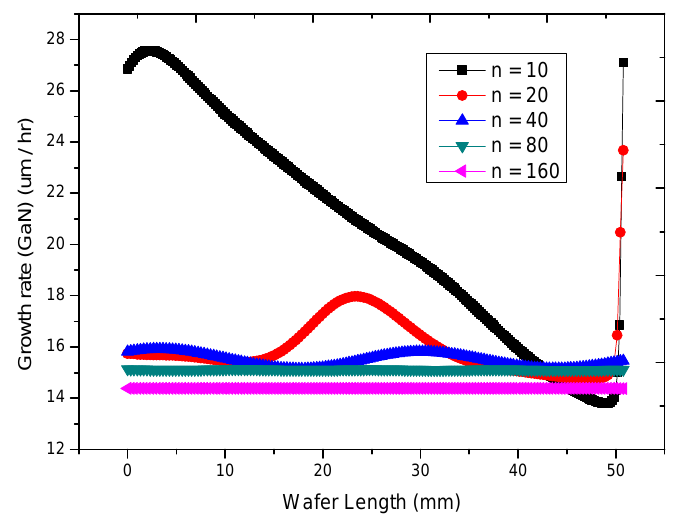
Figure 5. Predicted growth rate for each n .